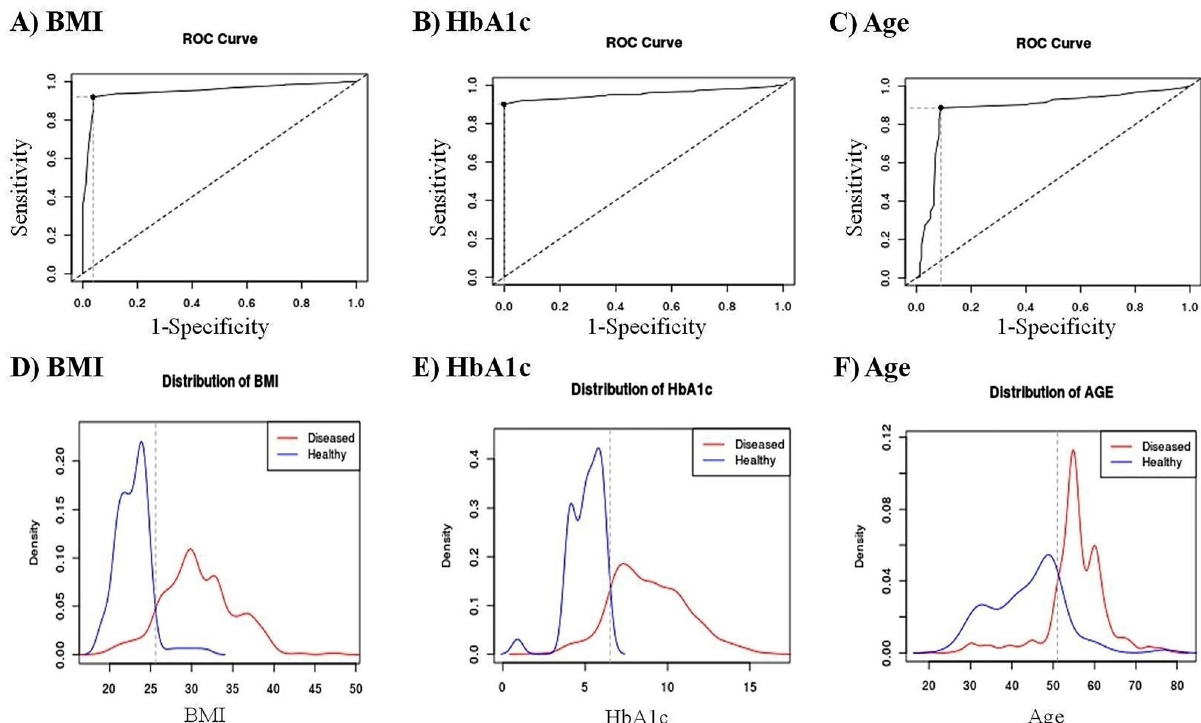
Figure 4. ( A – C ) The ROC curve of BMI, HbA1c, and age in predicting diabetes incidence. ( D – F ). The area under the ROC curve (AUC) is used to determine the best cut-off values for detecting incident